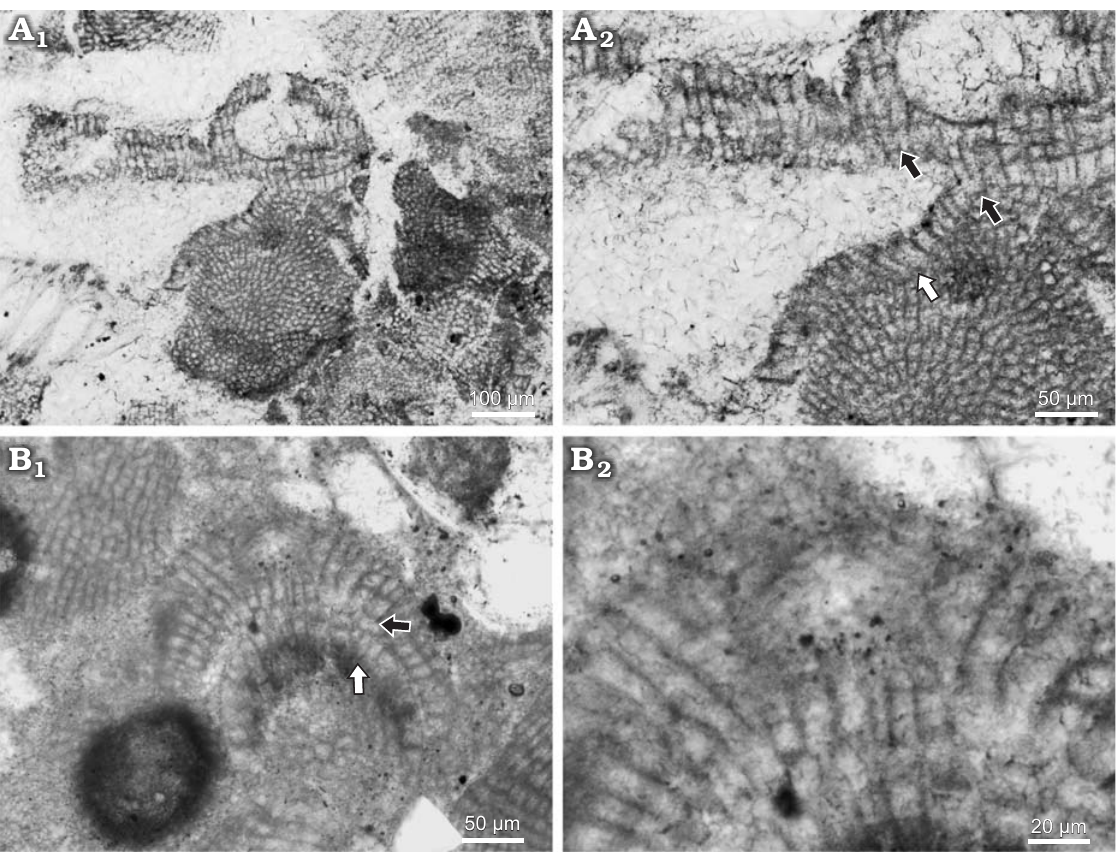
Fig. 7. Coralline alga Lithoporella sp. 1. A . Bi/tetrasporophyte, NHM B1855 (thin section 371111453), early Serravallian, Vývrat, Slovakia, Vienna Basin. A 1 . Encrusting growth form with prominent conceptacle; note type of the conceptacle with roof cells oriented perpendiculary to the chamber. A 2 . Palisade cells (white arrow) and lateral fusion of cells in adjacent filaments (black arrows). B . Male gametophyte, NHM B1856 (thin section 31011152), late Langhian, Stupava, Slovakia, Vienna Basin. B 1 . Spermatangial plant with encrusting growth form; black arrow point to the lateral cells fusions in adjacent filaments; white arrow point to the palisade cells. B 2 . Detail of the spermatangial conceptacle; note the type of the conceptacle with roof filaments running parallel with the chamber and bending upward to develop the pore